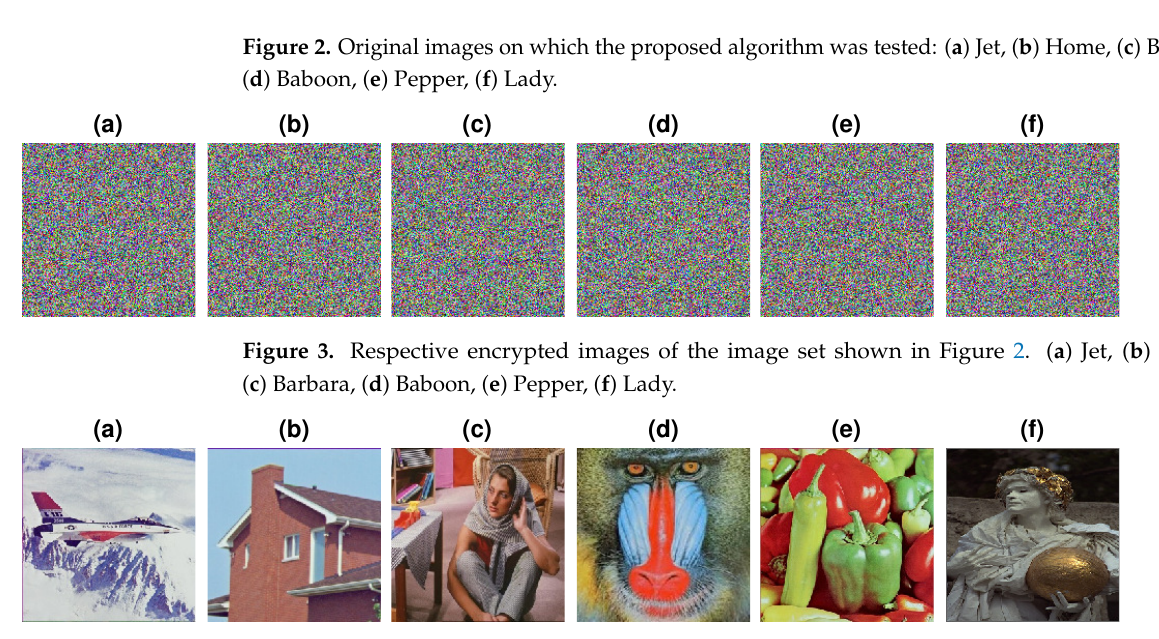
Figure 4. Respective decrypted images of the corresponding encrypted images shown in Figure 3. ( a ) Jet, ( b ) Home, ( c ) Barbara, ( d ) Baboon, ( e ) Pepper, ( f )